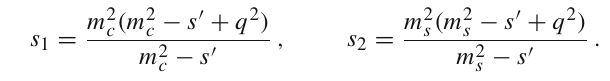
Fig. 4 Non-perturbative diagrams for the off-shell K ∗ meson